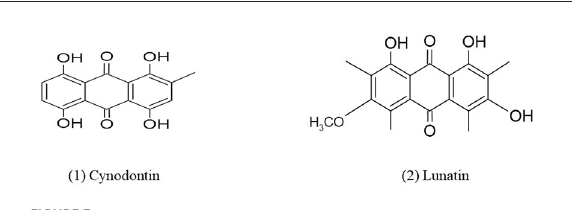
FIGURE3 Chemical structures of bioactive compounds of quinone family of Curvularia spp. (1) Cynodontin, and (2) Lunatin.